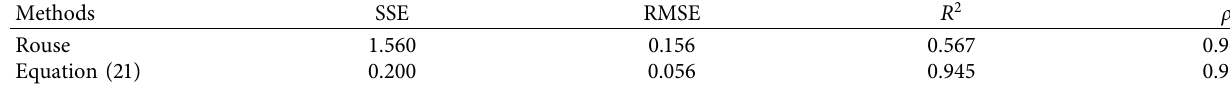
Table 3: Verifcation error of suspended sediment vertical distribution.